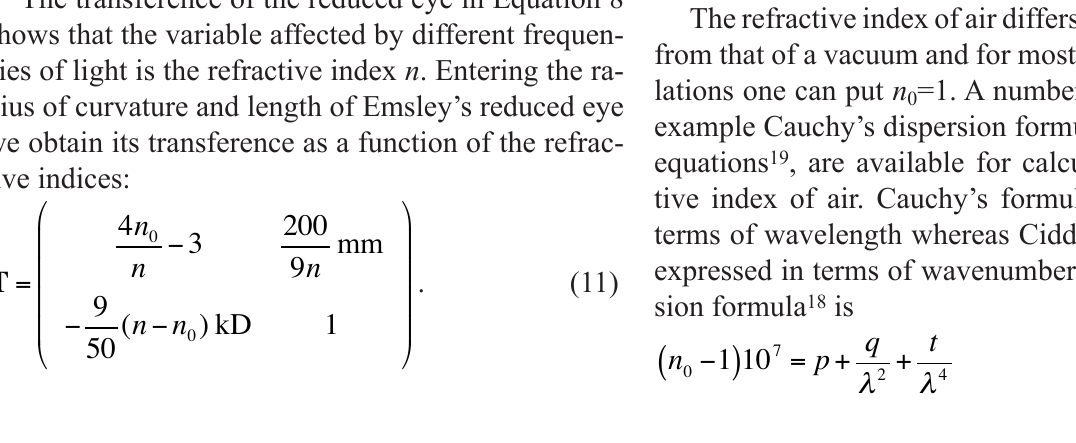
Table 1. The colours of the six reference points and their frequencies, vacuum wavelengths, refractive indices for the reduced eye, ametropias, powers for the reduced eye and refractive compensations are provided. The last row shows the chromatic difference across the spectrum 428.3 to 749.5